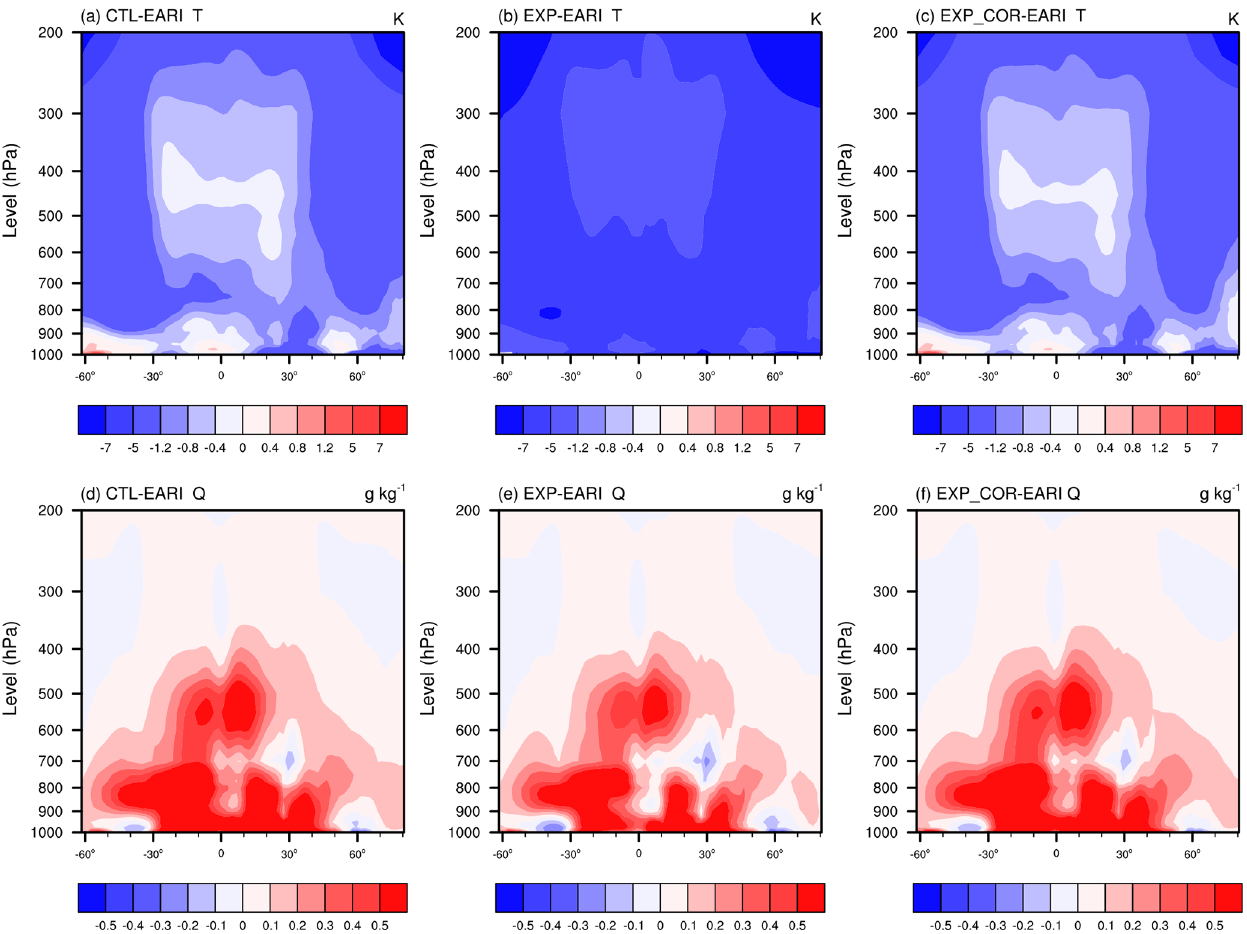
Figure 13. Annual and zonal mean cross sections of the (a–c) temperature and (d–f) specific humidity differences for (a, d) CTL-ERAI, (b, e) EXP-ERAI and (c, f)